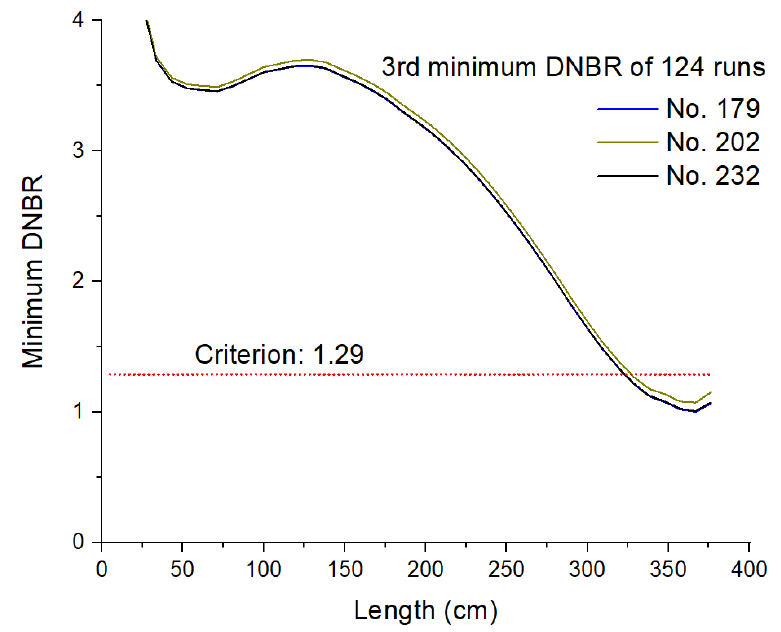
Figure 12. The results of the third minimum DNBR on the three fuel assemblies.